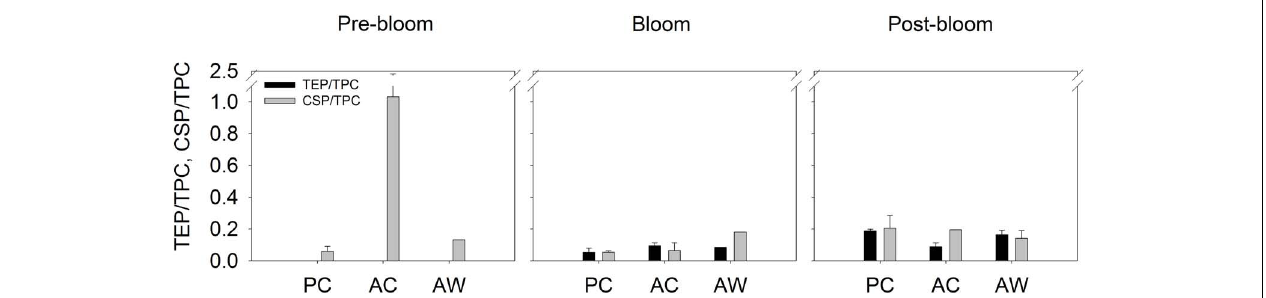
FIGURE 4 | Content of TEP (mg XG eq. L − 1 ) and CSP (mg BSA eq. L − 1 ) normalized by the amount of TPC in the aggregate fraction of each treatment and sampling time. Black bars represent the TEP/TPC ratio and gray bars represent CSP/TPC. Bars show the average of all the roller tanks that formed aggregates in each treatment and bloom period. For Pre-bloom: PC ( n = 3RT), AC ( n = 4 RT), and AW ( n = 2RT); and for Post-bloom PC ( n = 2 RT), AC ( n = 2 RT), and AW ( n = 2